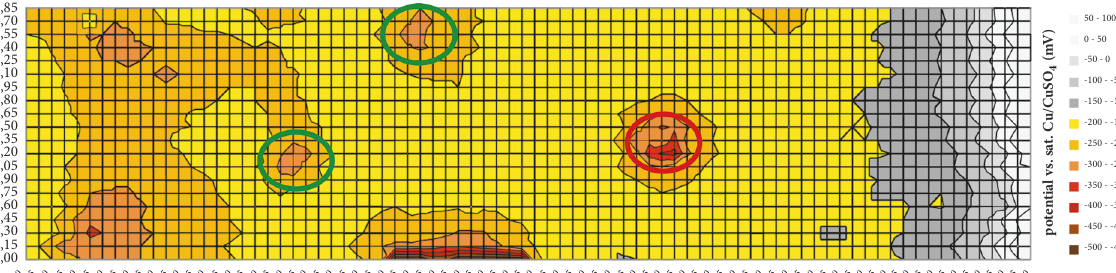
Figure 6: Potential mapping results of the large-scale specimen—two anodes and the galvanized stairway.